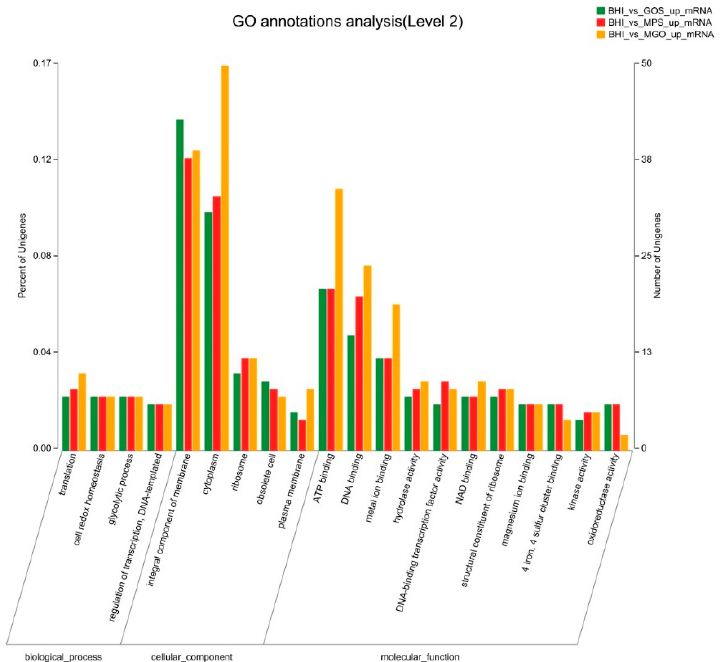
Figure 4. Gene Ontology (GO) analysis of A. muciniphila cultured with different prebiotics for 6 days. The right y -axis represents the number of unigenes of a specific category within the main category, and the left y -axis represents the percentage of unigenes of a specific category within the main category. A bar indicates the number of upregulated genes.